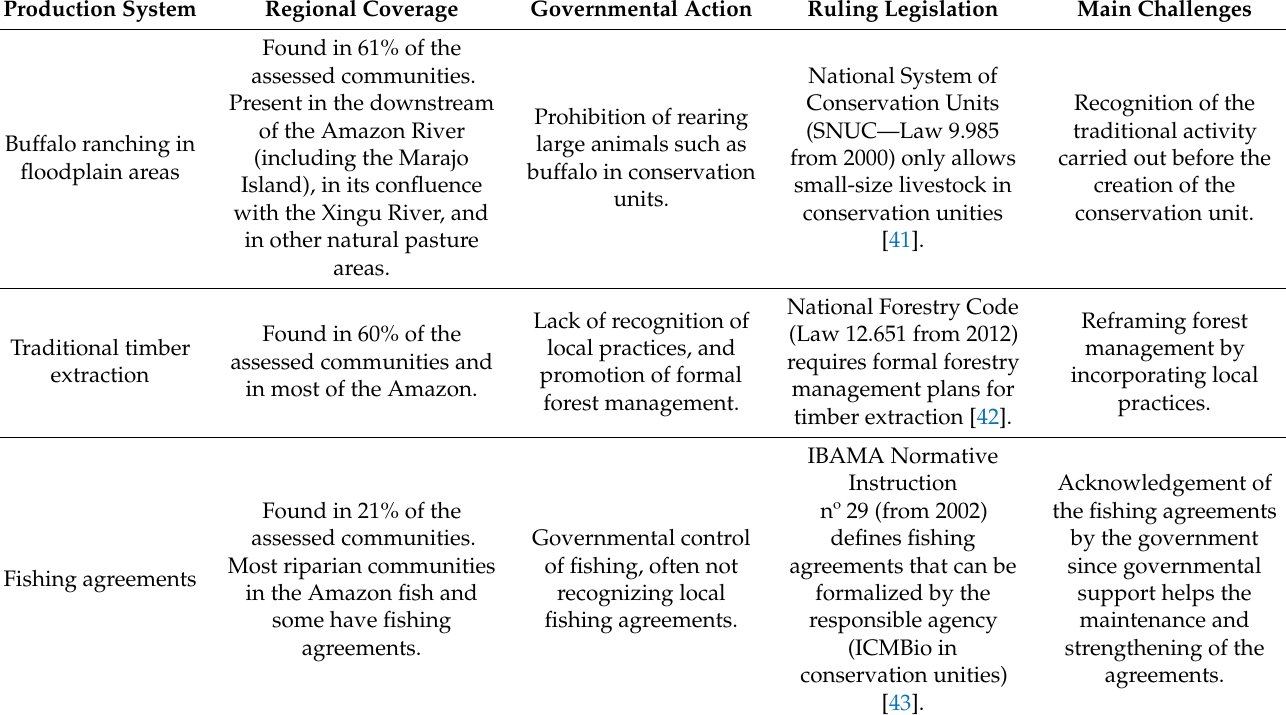
Table 3. Cross-comparison of national regulatory frameworks with the local management